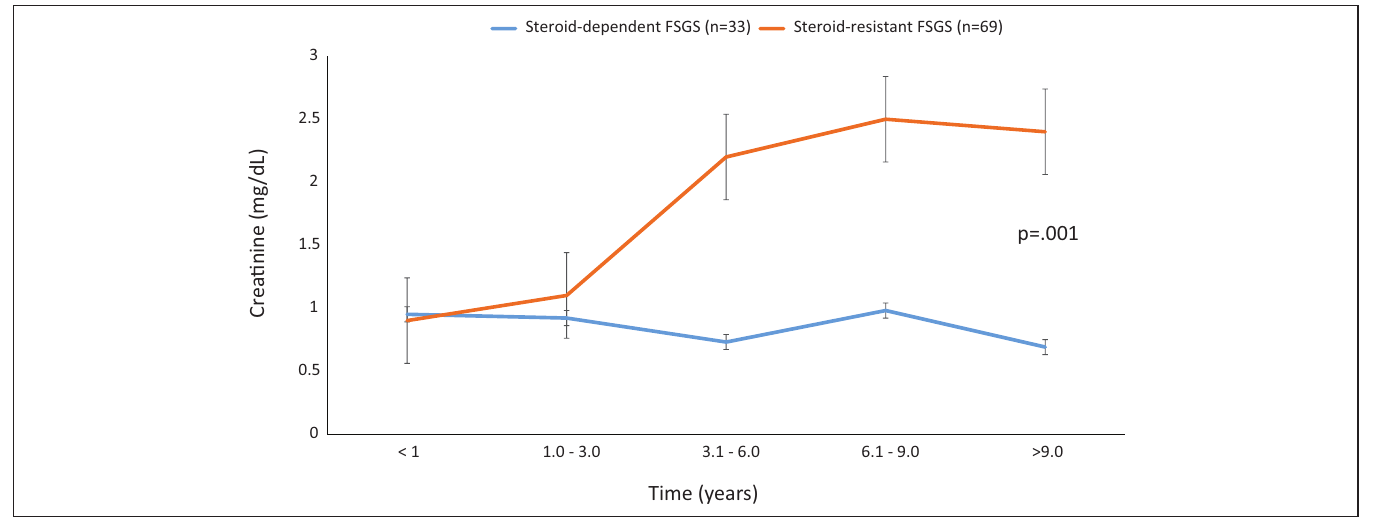
Figure 3. Comparison of mean serum creatinine between steroid-dependent and steroid-resistant focal segmental